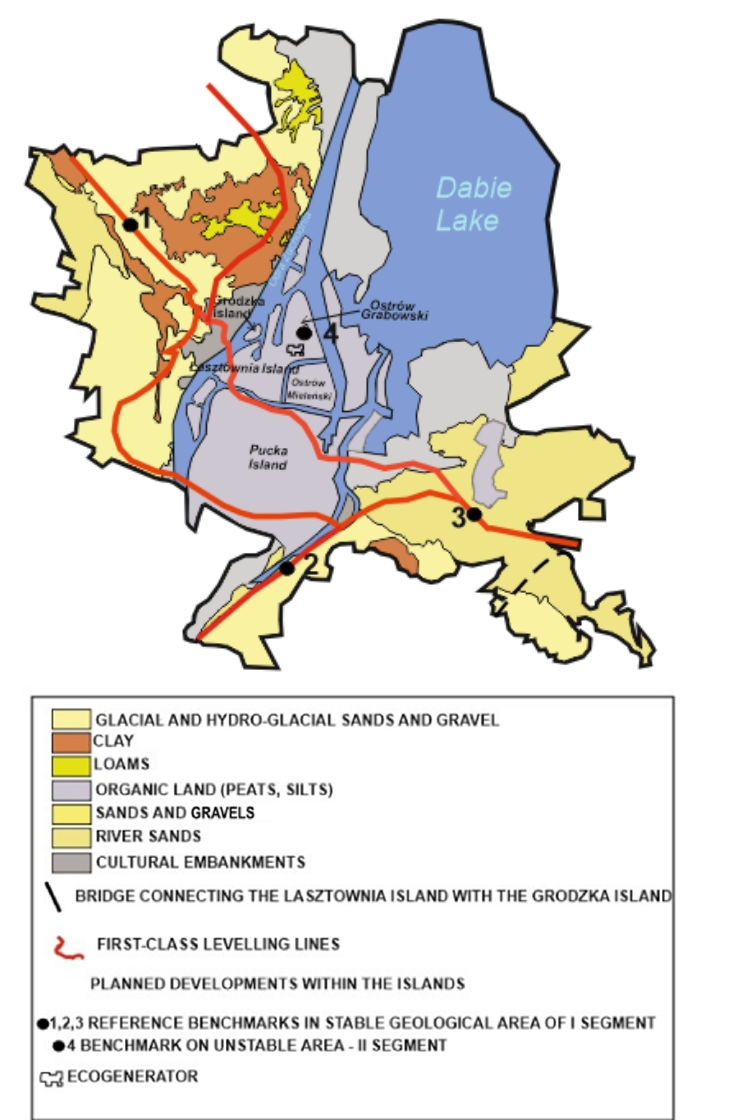
Figure 2. Geology of Szczecin area with benchmarks of first and second segment of control and measurement system.